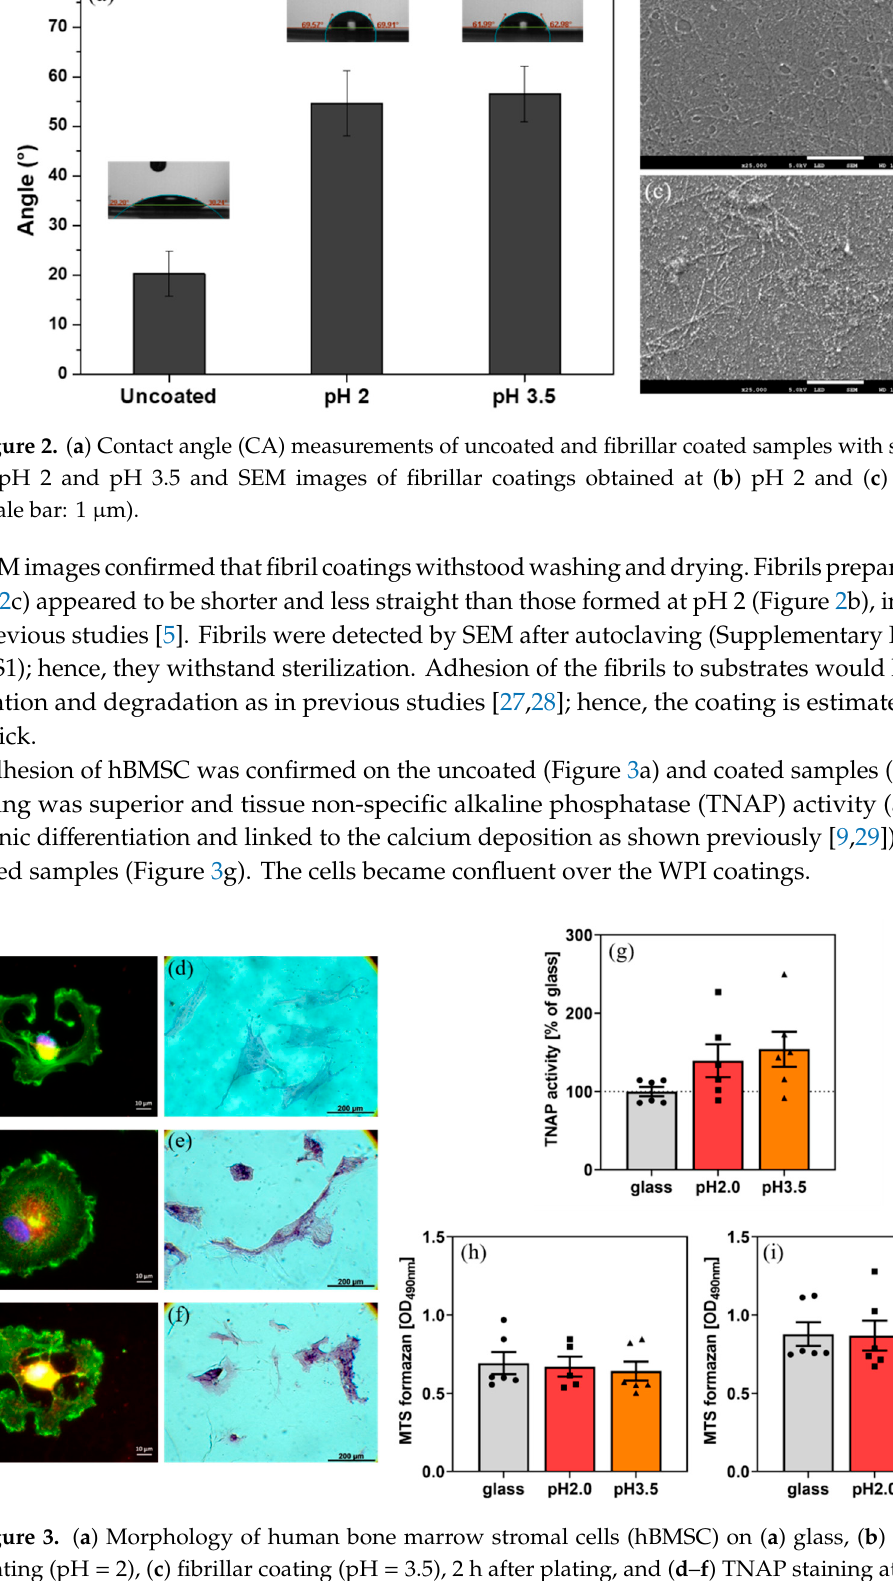
Figure 3. ( a ) Morphology of human bone marrow stromal cells (hBMSC) on ( a ) glass, ( b ) fibrillar coating (pH = 2), ( c ) fibrillar coating (pH = 3.5), 2 h after plating, and ( d – f ) TNAP staining at day 11 after plating, respectively. ( g ) TNAP activity on different substrates (day 11) and metabolic activity results at ( h ) day 2 and ( i ) day 4 after plating.